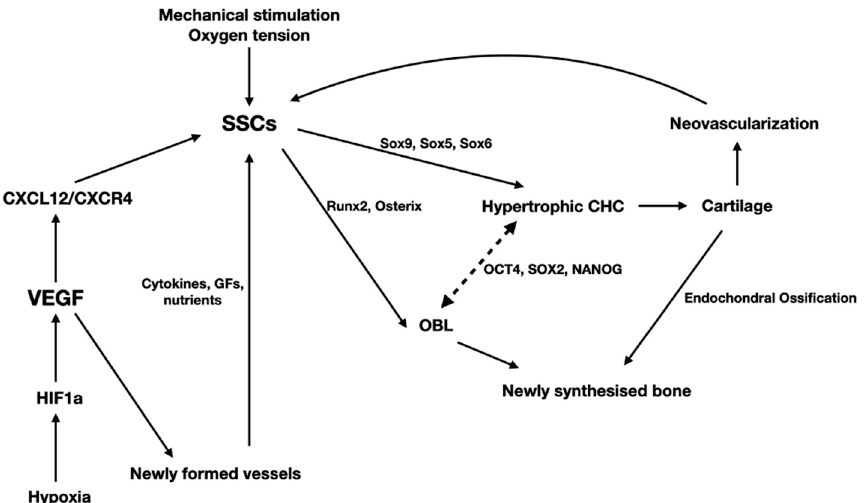
Figure 5. This graph illustrates the cells, signaling pathways and transcription factors that regulate the late stage of the anabolic phase of fracture-healing that leads to the synthesis of fibrocartilage and eventually bone, via a process the recapitulates endochondral ossification (see text for details)